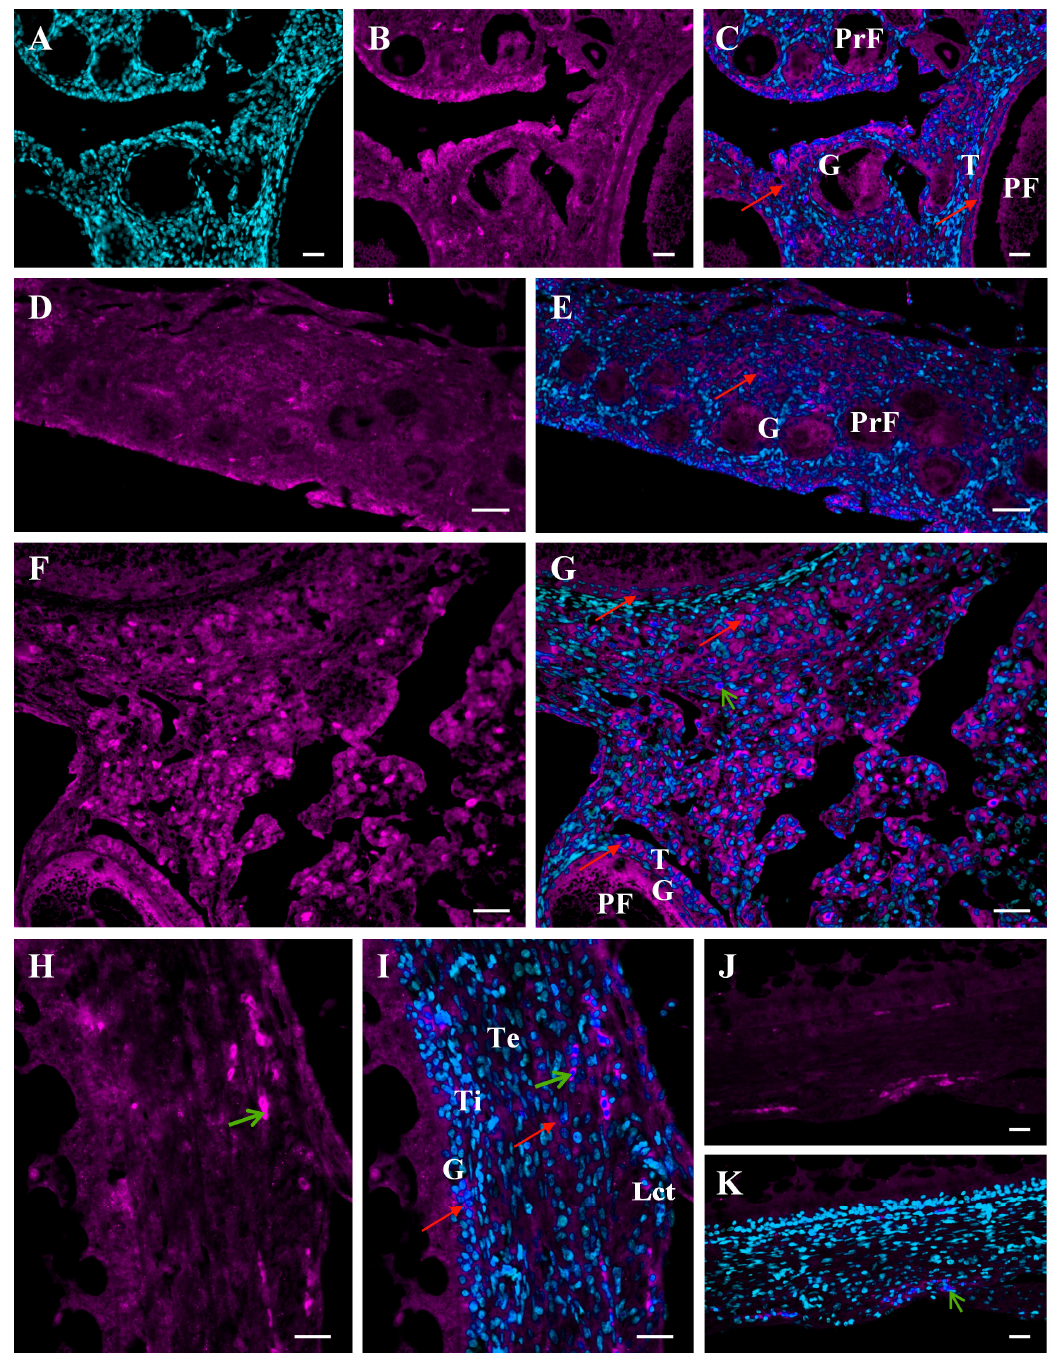
Figure 2. Immunofluorescent localization of the MMP-2 protein in the ovary of a growing chicken. Representative micrographs of the chicken ovary obtained about 6 weeks ( A – C ) and 4 weeks ( D , E ) before sexual maturation and of the ovarian stroma obtained from a mature hen ( F , G ). The wall of the yellowish follicle obtained from the ovary about two weeks before maturation ( H – K ). Positive fluorescence for MMP-2 (magenta; red arrows) present in ovarian stromal cells as well as the entire wall of primordial follicles (PrF; composed of one layer of granulosa cells), primary follicles (PF; composed of one layer of granulosa cells and a thin theca layer), and yellowish follicles (composed of several layers of granulosa cells, theca interna and externa, and epithelium with loose connective tissue). Negative control sections incubated without the primary antibody (Abcam, Cambridge, UK) do not exhibit positive staining ( J , K ), excluding red blood cells which always show nonspecific fluorescence (green arrows). DAPI staining (cyan) of the nucleus only ( A ). Specific immunoreactivity for MMP-2 ( B , D , F , H ). Merger of DAPI and MMP-2 ( C , E , G , I , K ). Abbreviations: G, granulosa; T, theca; Lct, epithelium with loose connective tissue; Ti, theca interna; Te, theca externa. Scale bars = 20 µ